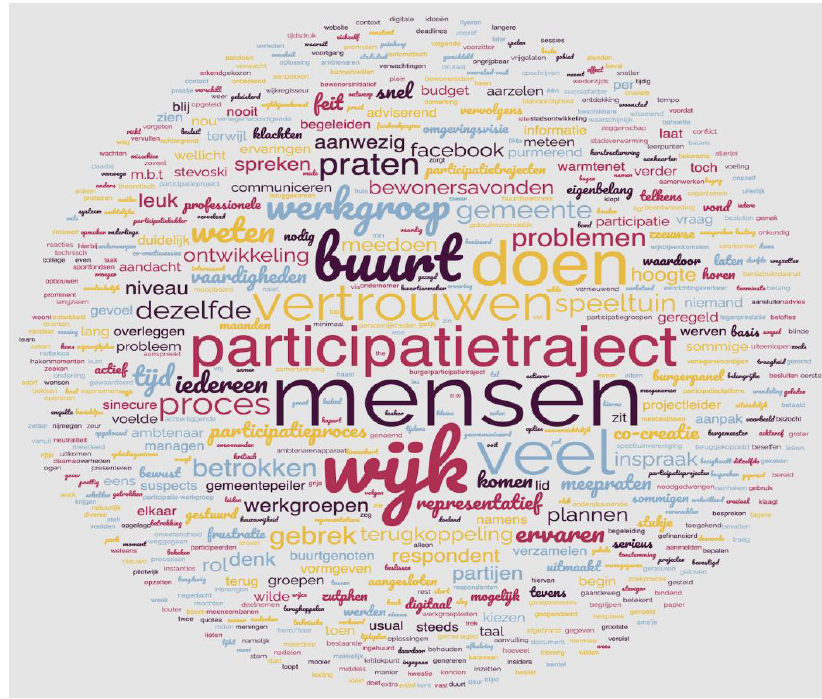
Figure 5. A content cloud of key words in 21 Rotterdam energy studies.